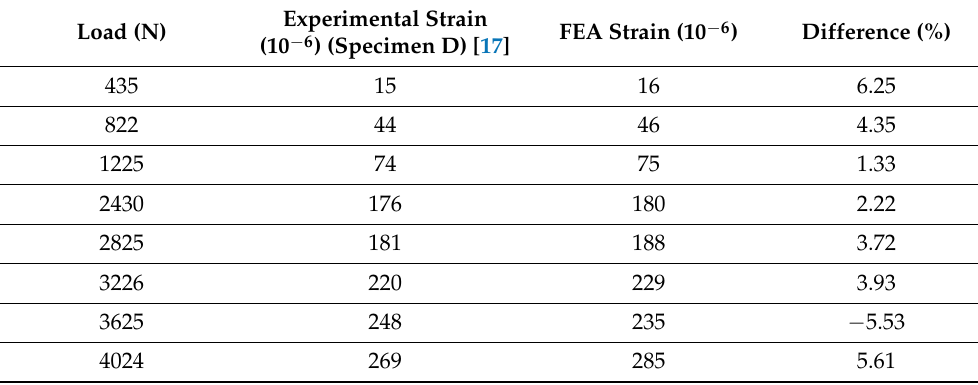
Table 1. Comparison of the FEA results with the experimental results [17]. Load